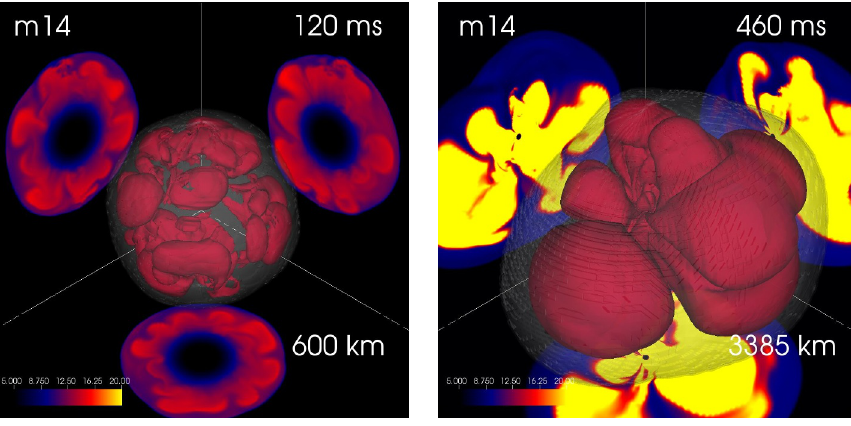
Figure 1. Entropy isosurface within the inner region of the exploding SN 1987A progenitor at 120 ms (left panel) and 460 ms (right panel) after bounce. Note the di ff erent box sizes between the